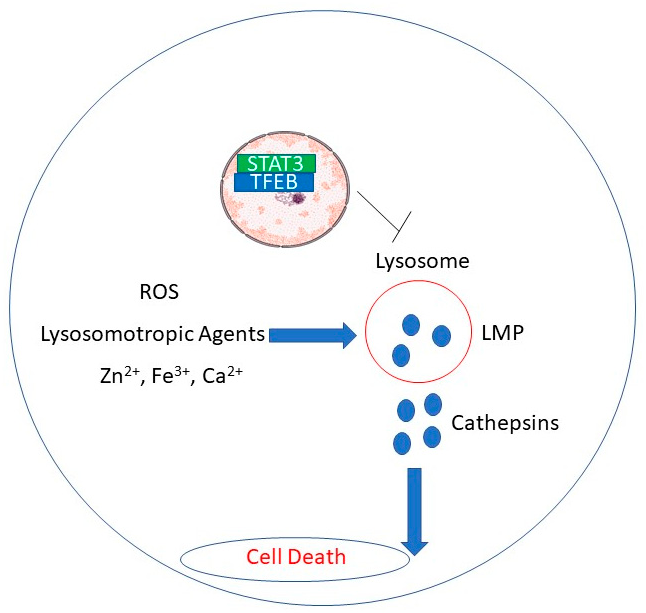
Figure 1. Putative mechanisms by which natural products induce LMP. In this review, we proposed that lysosomal disruption may preferentially kill tumors treated with natural products, representing a potential novel therapeutic option against malignancies. Lysosomes are an interesting target in cancer cells because of their bigger size and frailty compared to healthy cells [4,5]. LMP is a promising mode of therapy for cancers that are resistant to chemotherapy, radiation, or hormone therapy, due to its dis- tinct mode of action. Further studies are warranted to decipher the precise mechanisms by which natural products induce lysosomal cell death in cancer cells. Funding : This reserch received no external frunding. Institutional Review Board Statement: Not applicable. Informed Consent Statement: Not applicable. Data Availability Statement: Not applicable. Conflicts of Interest: The authors declare no conflict of interest. References 1.